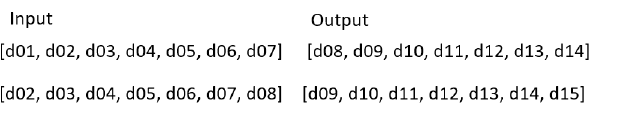
Figure 6. Example of overlapping weekly